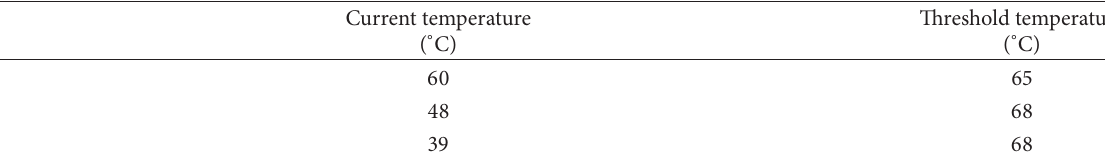
Table 20: Unified list (S2).